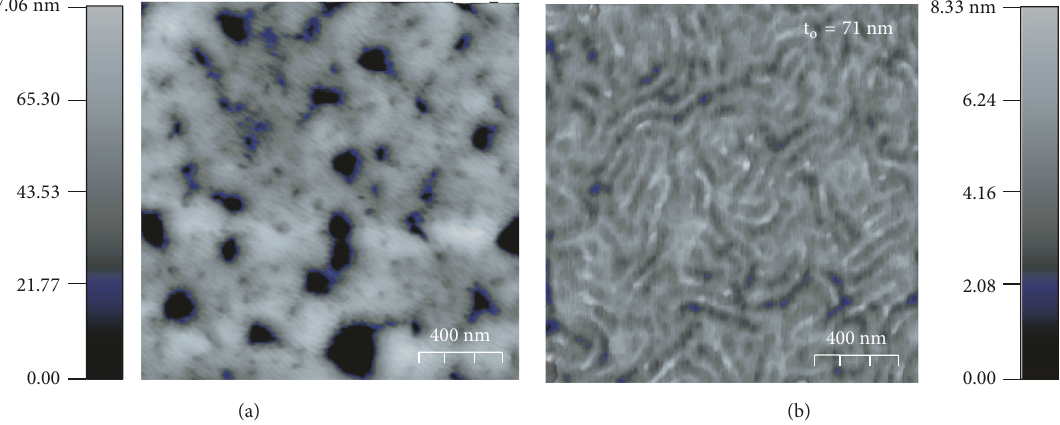
Figure 3: AFM height images of BCs thermally annealed (TA) at 170 ∘ C for 24 h. (a) M3 60/40, (b) M3 60/s40 (t